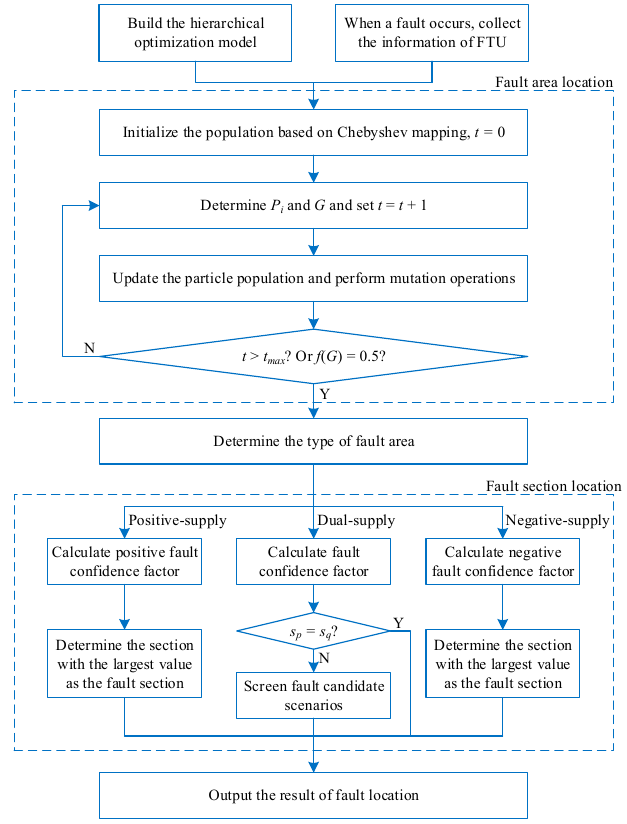
Figure 8. Flowchart of fault location.